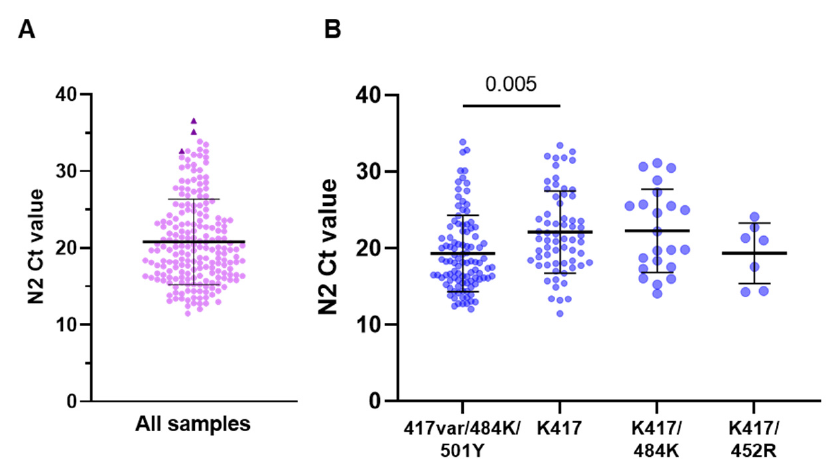
Figure 3. Distribution of N2 Ct values for ( A ) all samples and ( B ) the four most common genotypes detected. ( A ) N2 Ct values for all tested samples are displayed. Three samples that tested negative in the Spike SNP assay are highlighted (dark triangles) and had N2 Ct values of 32.6, 36.6, and 35.1. ( B ) N2 Ct values for the four most common genotypes detected. Bars represent mean Ct and standard deviation, and p -values for tested comparisons are displayed above the graph. Table 2. Genotypes detected in the Spike SNP assay, patient demographics, and the percent confirmed using amplicon sequencing.